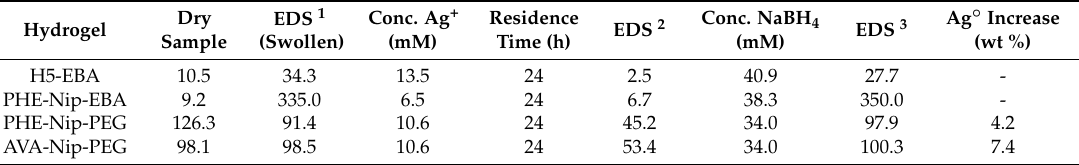
Table 2. Experimental conditions for the preparation of silver nanoparticles embedded hydrogels. Dry Hydrogel